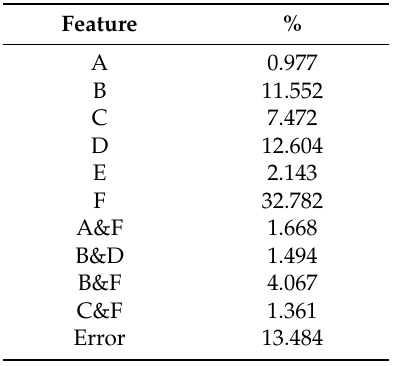
Table 5. Error reported by the ANOVA analysis and relative influence of the election of the input features on the global result when the Naïve Bayes algorithm is applied. Inputs: A = µ SMV